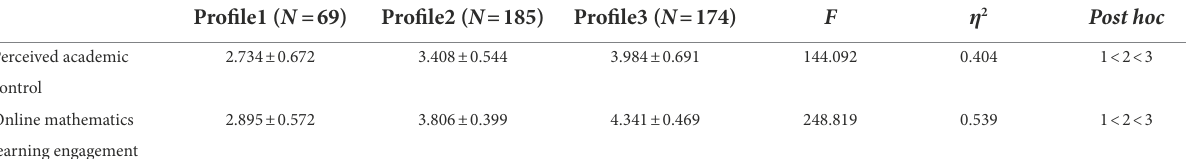
TABLE 4 Differences in Perceived academic control and online mathematics learning engagement across latent profiles (M ± SD).